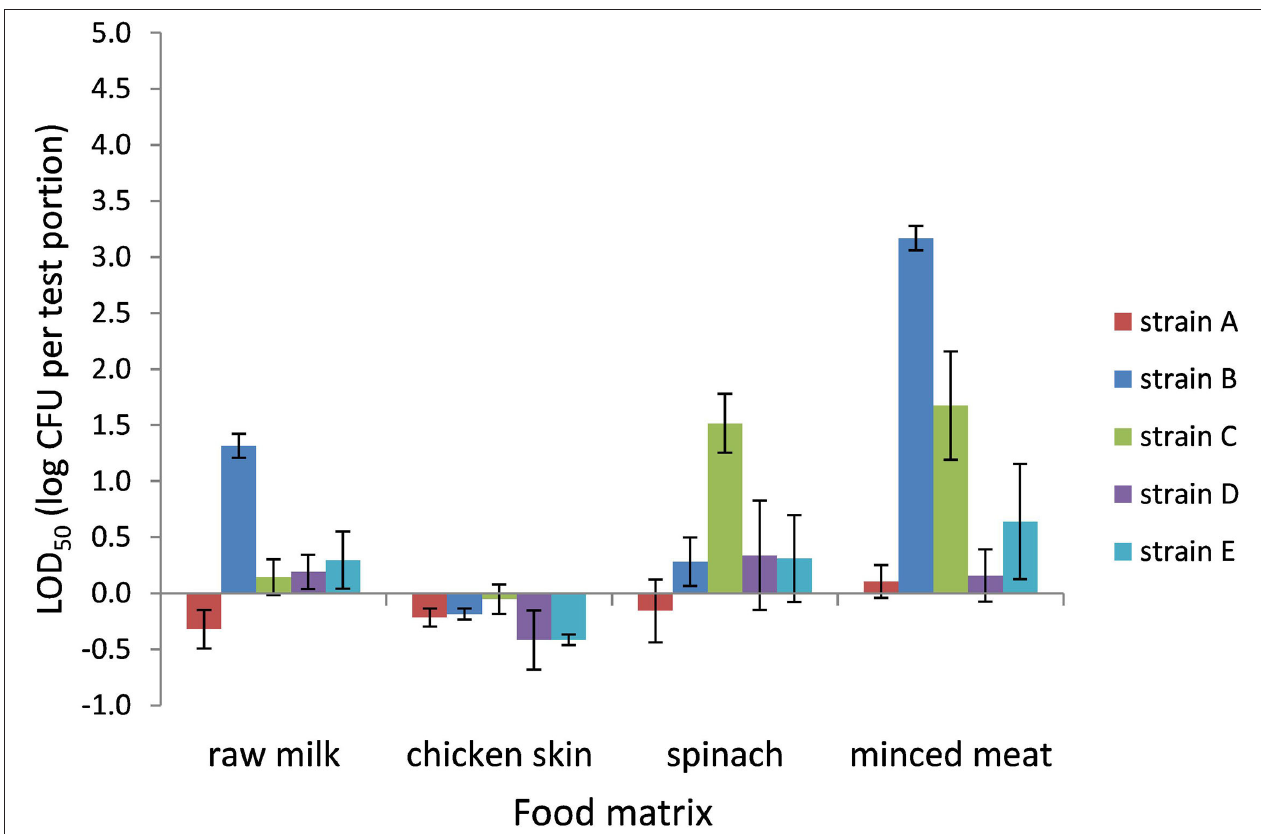
FIGURE 1 | LOD 50 of C. jejuni strains A, B, and D and C. coli strains C and E. Enrichment in Bolton broth, including food matrices, namely, raw milk ( n = 3), chicken skin ( n = 2–5), frozen spinach ( n = 3), and frozen minced meat ( n = 3–4). Error bars indicate the standard